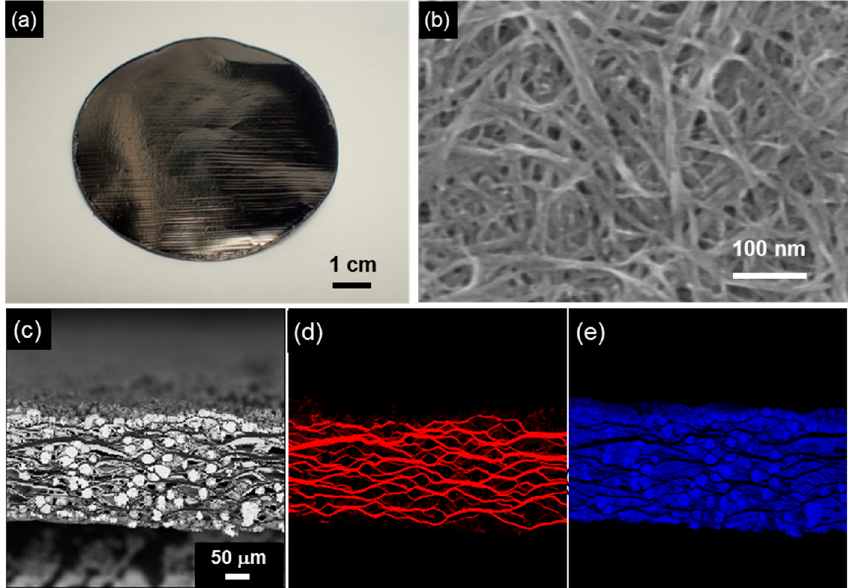
Figure 15. SWCNT/Cu composite sheet by electrodeposition using a SWCNT sheet as the template. ( a ) Appearance of SWCNT sheet, ( b ) Surface SEM image of the SWCNT sheet, ( c ) Cross-sectional SEM image of the CNT/Cu composite sheet by electrodeposition using a plating bath with additives, ( d ) C distribution of ( c ), and ( e ) Cu distribution of ( c ). (Figure 15 is adapted from